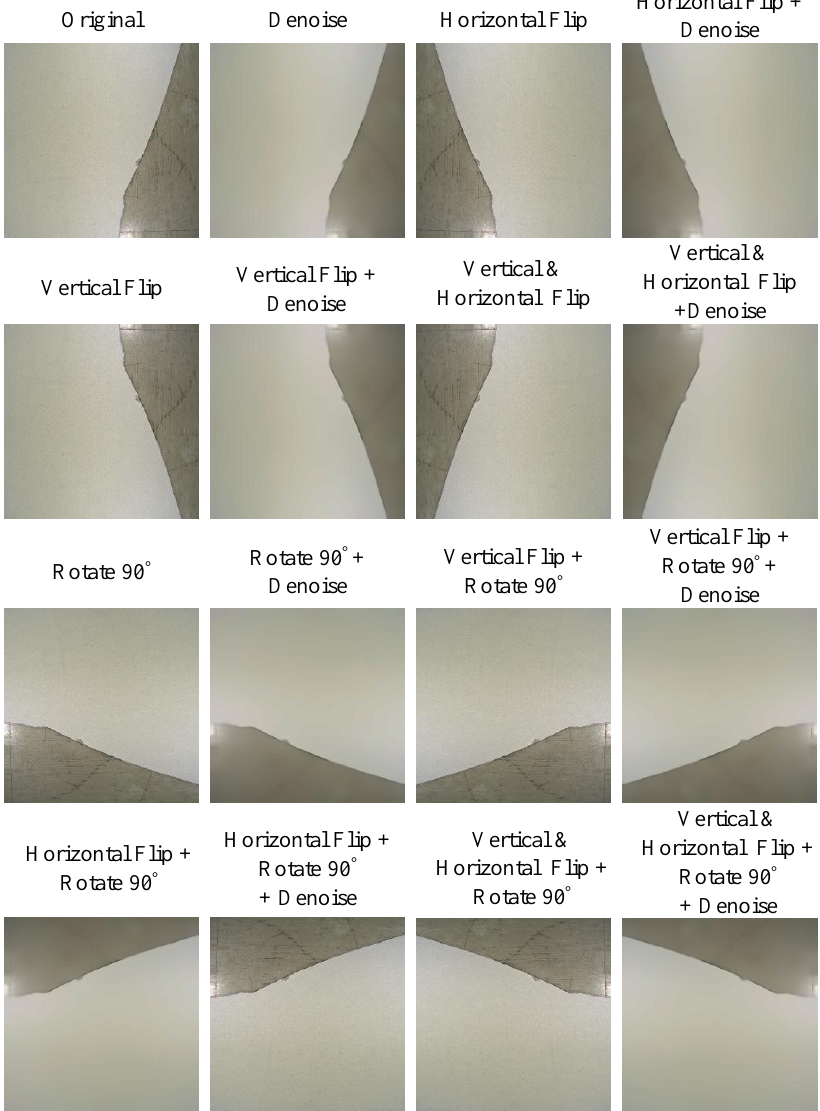
Figure 11. Data augmentation by using fifteen different image processing operations.